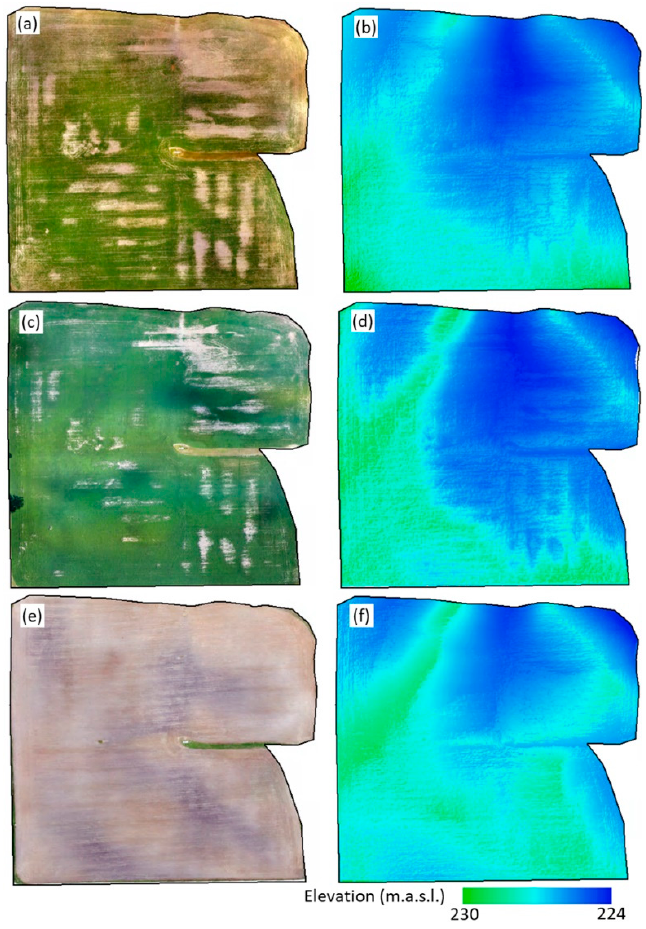
Figure 5. Orthomosaic maps and Digital Surface Models (DSMs) from UAS data collected at different times ( a , c ) on 15 July 2019, ( b , d ) on 6 August 2019, ( c , e ) on 24 October 2019. The maps on the left side are DSMs while on the right side are the corresponding orthomosaic maps.